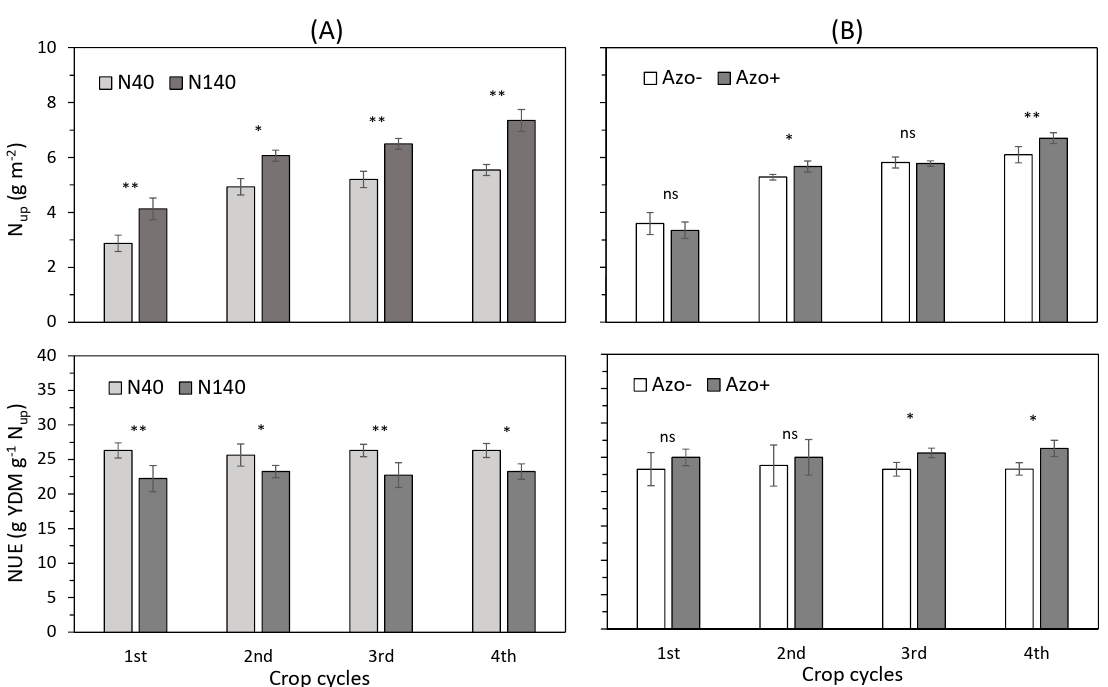
Figure 2. Effects of the ( A ) N level and ( B ) Azoxystrobin on the N uptake (N up , g m − 2 ) and nitrogen use efficiency (NUE, g YDM g − 1 N up ) of wild rocket in the four crop cycles. YDM = yield dry matter; Azo − = control without Azoxystrobin, Azo + = with Azoxystrobin; N 40 = 40 kg ha − 1 of N, N 140 = 140 kg ha − 1 of N. Vertical bars indicate SD ( n = 6). ns, *, ** indicate F test not significant or significant at p ≤ 0.05 and p ≤ 0.01, respectively.